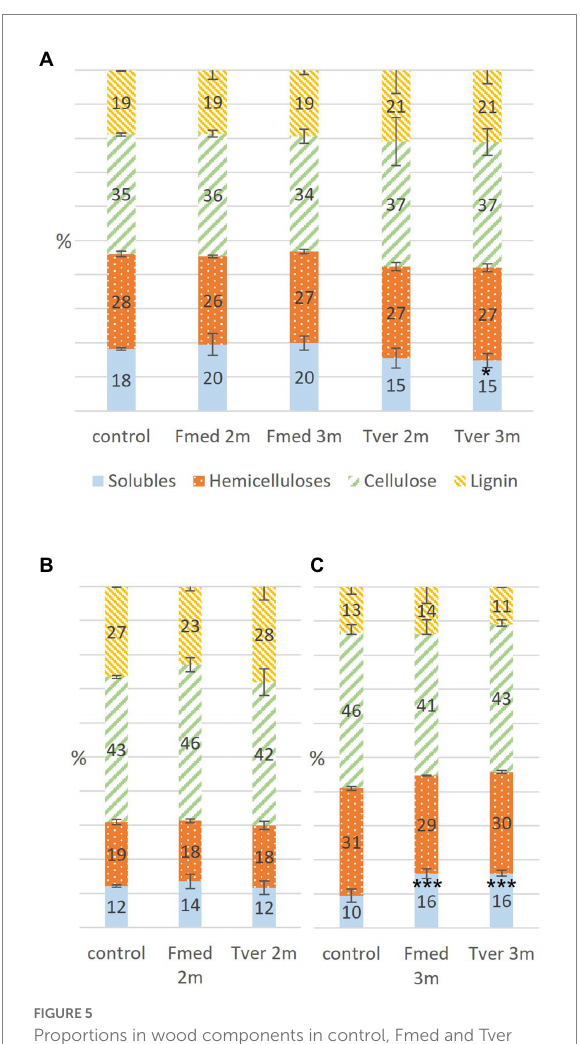
FIGURE 5 Proportions in wood components in control, Fmed and Tver cultures on (A) grapevine, (B) spruce and (C) beech at 1 month (1 m), 2 months (2 m) or 3 months (3 m) of culture. Significant differences are given compared to the percentage in control according to Student–Newman–Keuls test, and are indicated by *** for p -values < 0.001, ** for p -values < 0.005 and * for p -values <